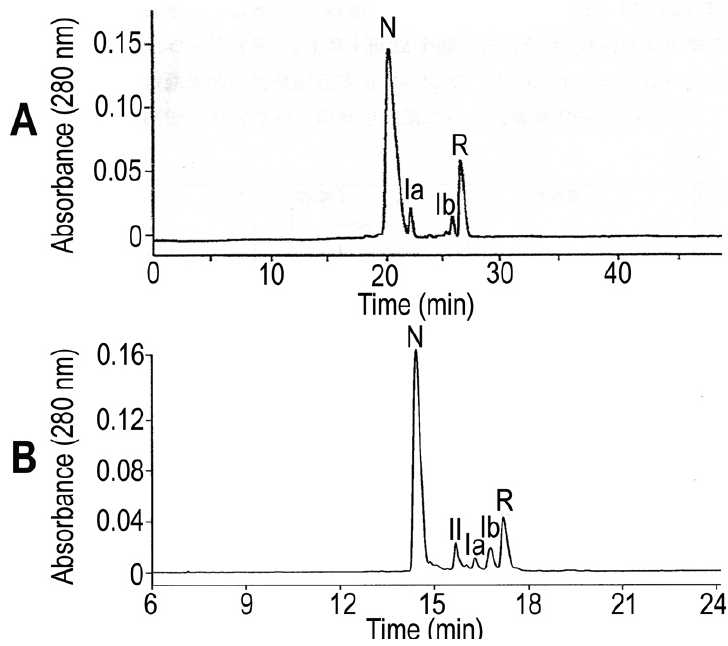
Figure 2. Analytical RP-HPLC profile of partial reduction of HNTX-III ( A ) and HNTX-IV ( B ) by TCEP. The chromatographic peaks represent intact peptides (N), intermediates with two disulfide bonds (II) and one disulfide bond (Ia and Ib), and completely reduced peptide (R),